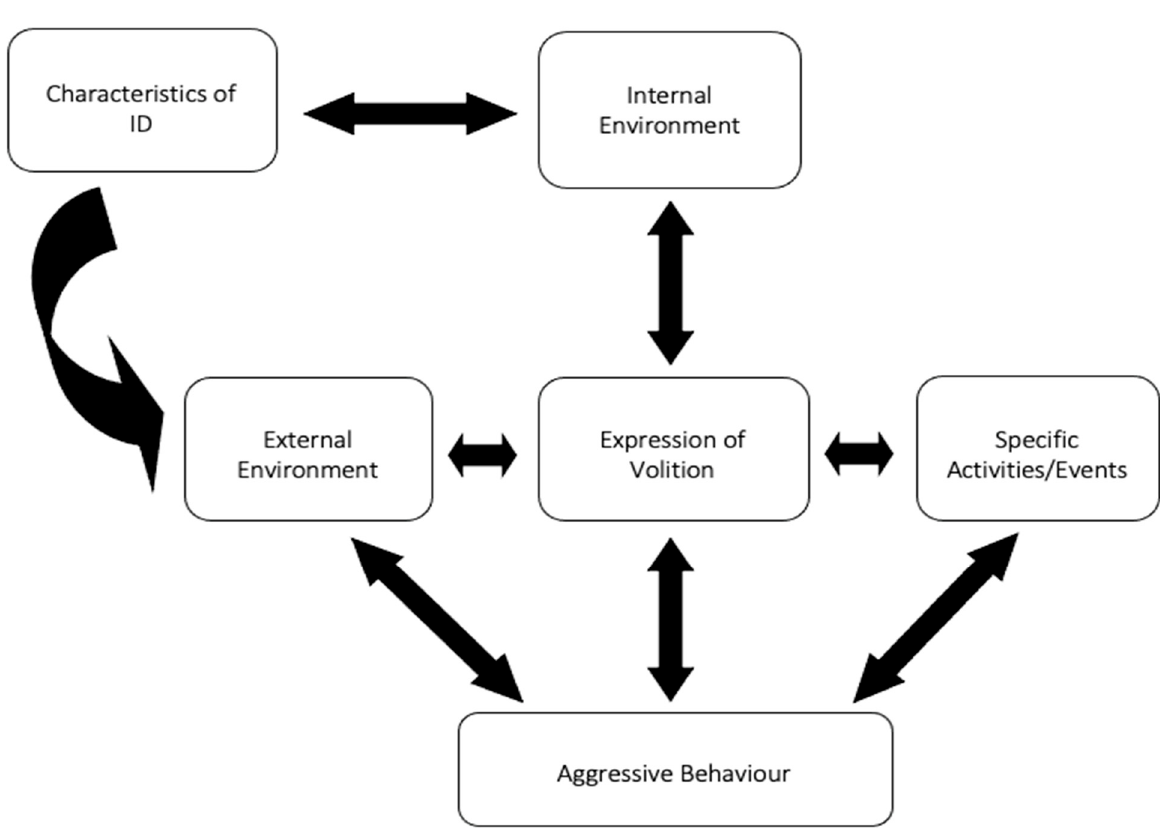
Figure 1. Schematic map of triggers and motivations for challenging behaviour identified by the caregivers [36].